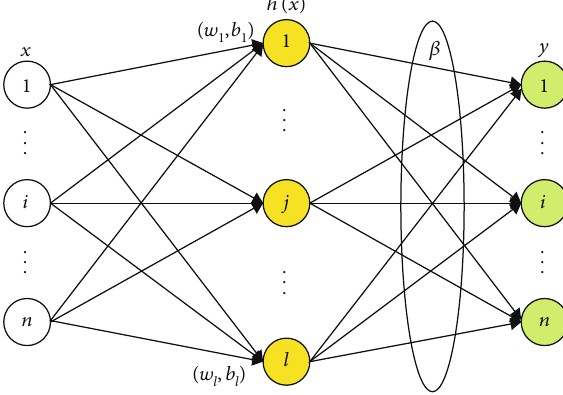
Figure 7: Schematic diagram of the parameter calculation method of the extreme learning